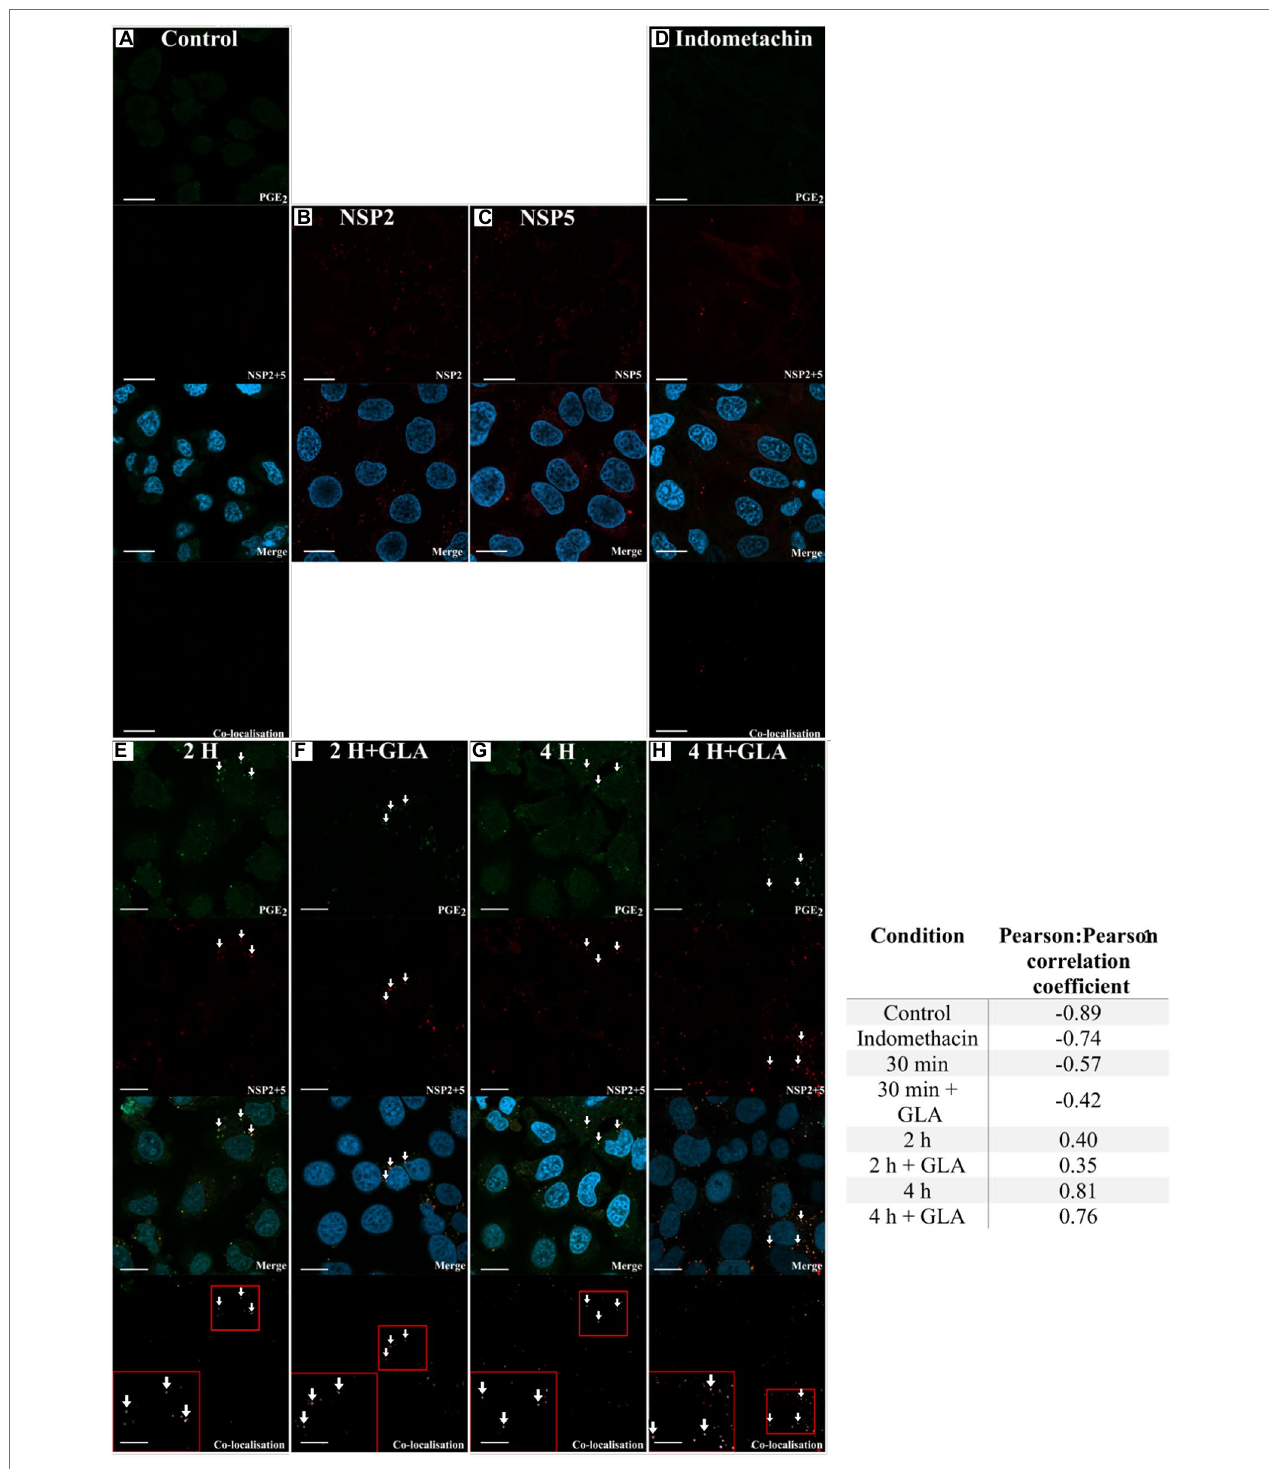
FIGURE 3 | Laser scanning microscopy images showing co-localisation between RV and PGE 2 . The presence of co-localisation (white arrows) between PGE 2 (green) and RV NSP2 and NSP5 (red) was evaluated using Coloc2 in ImageJ. Blue DAPI-staining indicates cell nuclei. (A) The no-virus control showed no detection of RV. The ability of the (B) anti-NSP2 and (C) anti-NSP5 antibodies to detect RV was independently assessed. (D) The required inclusion of indomethacin shows no detection of PGE 2 . After 2 h post-infection, NSP2 and NSP5 were detected in both (E) GLA unsupplemented and (F) supplemented cells, with co-localisation with PGE 2 first detected as suggested in the merge and confirmed in the co-localisation panels. Co-localisation increases at 4 h post-infection both in